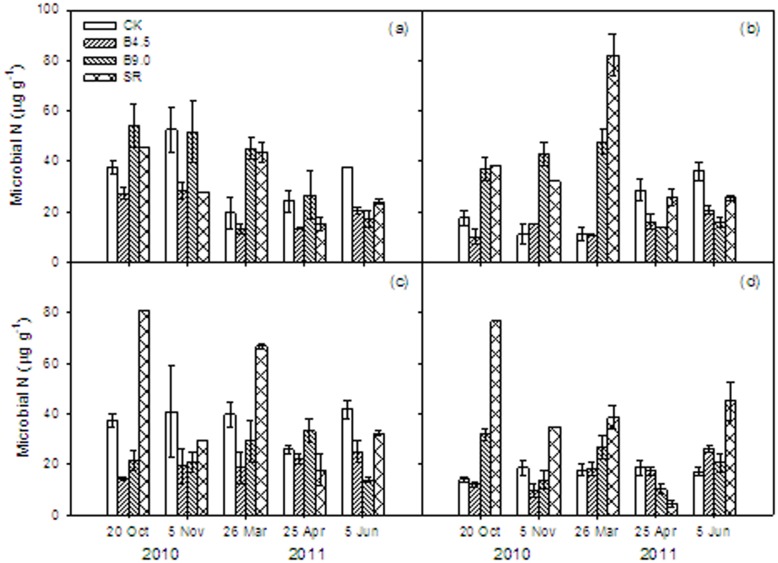
Microbial biomass nitrogen (MBN) under different treatments (CK: control, B4.5: 4.5 t ha−1 yr−1 biochar addition, B9.0: 9.0 t ha−1 yr−1 biochar addition, SR: incorporation of wheat straw) and different soil depths (a: 0–5, b: 5–10, c: 10–20, and d: 20–30 cm) during winter wheat season.Vertical bars represent the standard errors for means of each treatment (n = 3).